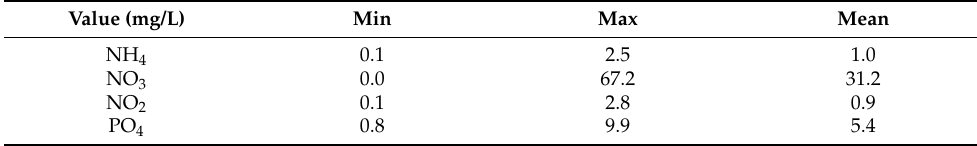
Table 4. Concentration of biogenic substances in the renewed water